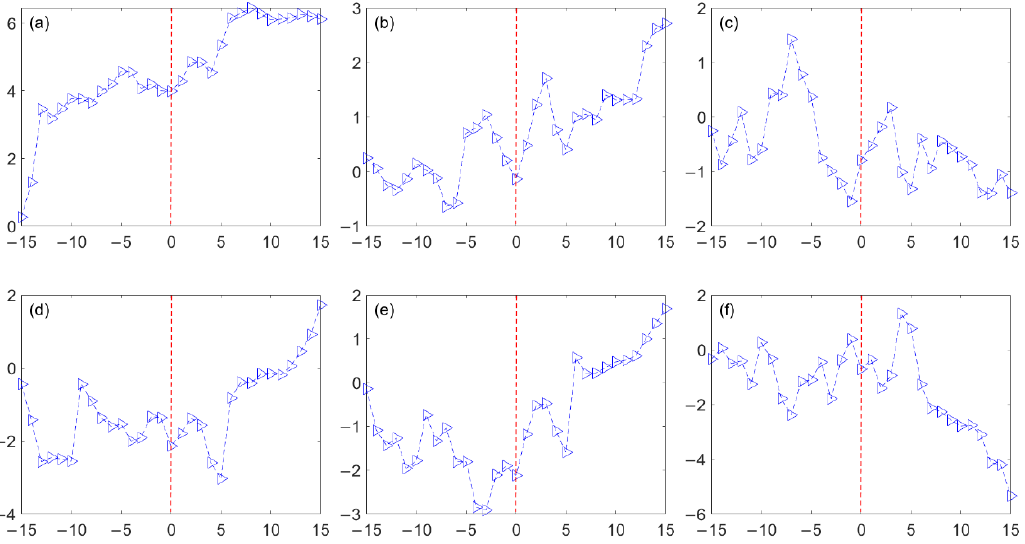
Figure 5. Strike of the government policy A1 on the outlier of net spillover effect: ( a – f ) show the outlier of the net spillover between the carbon market (CT) and oil (OPI), electricity (PI), steel (SI), chemicals (CI), non-ferrous metals (NFMI), and banking (BI) sectors, respectively.